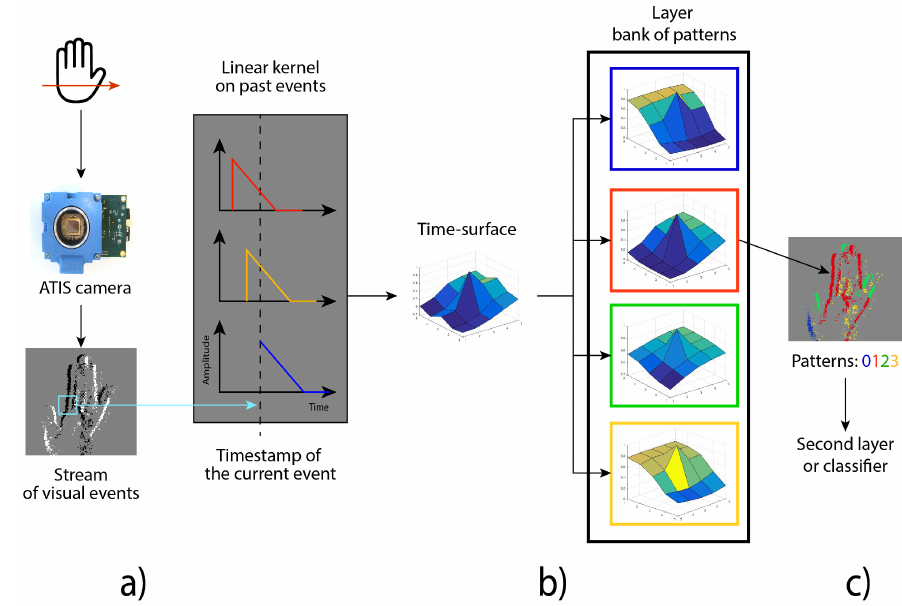
Figure 3. Example of a HOTS layer processing workflow. An input stimulus is processed by the sensor, sending a stream of events with (x,y) addresses and an ON/OFF polarity ( a ). The timestamp context of the incoming event is processed by applying a linear decay, creating the time-surface ( b ). Using the Euclidean distance, the time-surface is compared with the bank of prototypes; the closest one will send out an event with the same (x,y) but with the corresponding ID of the prototype. Finally, the events are sent out to another layer or integrated over time in order to generate a histogram, which is then processed by a classifier ( c